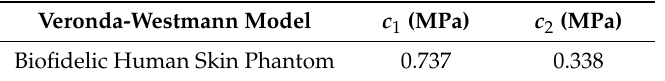
Table 1. Average hyperelastic curve fitting parameters for human skin phantoms.